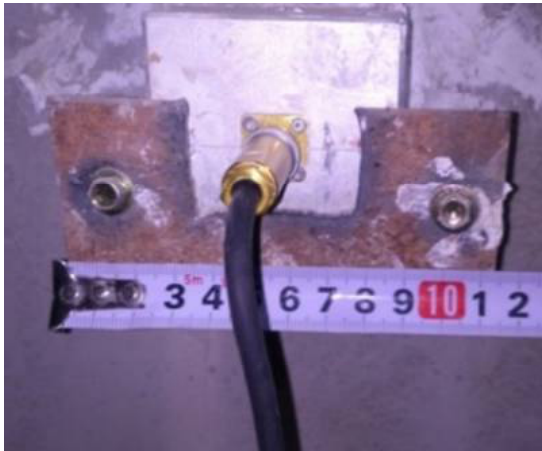
Figure 7. Transducer for the vibration measurements.